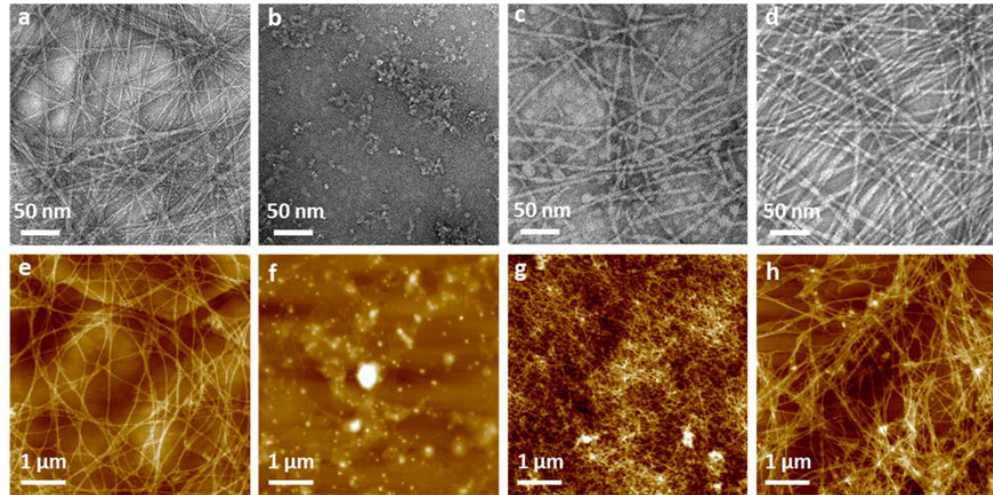
Figure 4. Nano- and microstructure of hydrogels (top panel TEM images and bottom panel AFM images). ( a , e ) Fmoc-FRGDF; ( b , f ) Fmoc-PHSRN; ( c , g ) Fmoc-FRGDFPHSRN and ( d , h ) peptide mixture of Fmoc-FRGDF/Fmoc-PHSRN (1:1, w / w ).